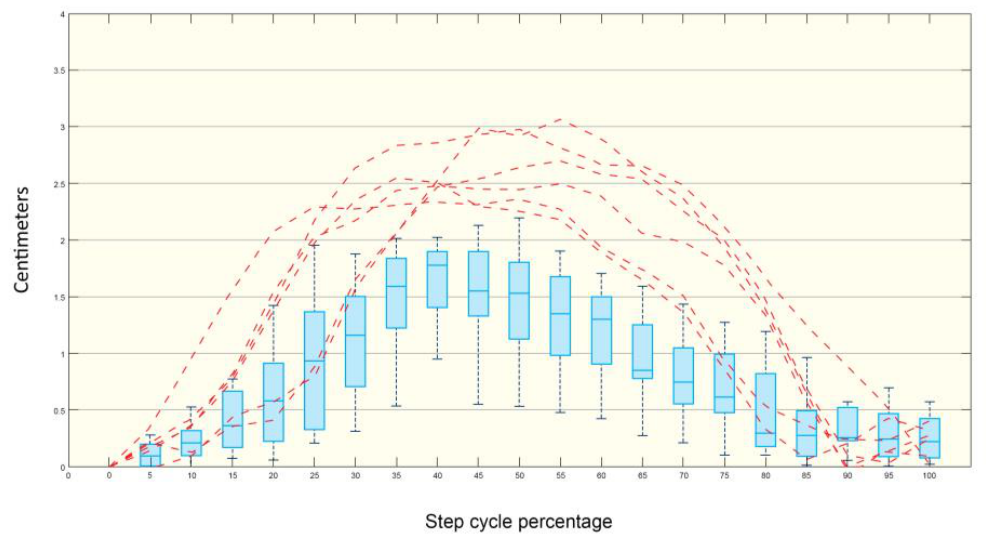
Figure 5. Control mice metatarsal joint displacement in boxplots. Dashed lines indicate a qualitative comparison between control and mouse 7. The red lines show the dissimilarity existing between the cycle percentages in the mice of the acute-infected group compared to the control group.